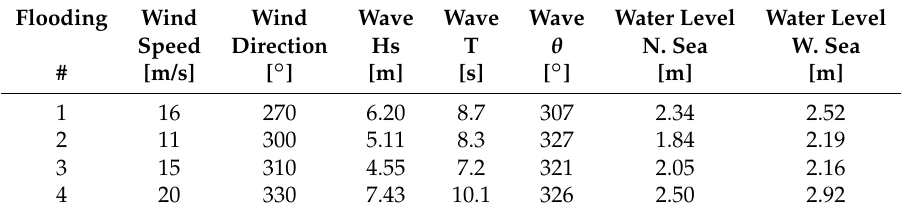
Table A1. Boundary conditions for observed floodings at high tide a